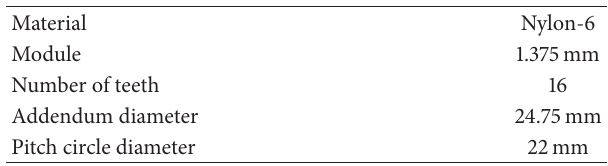
Table 8: Planet gear specification.